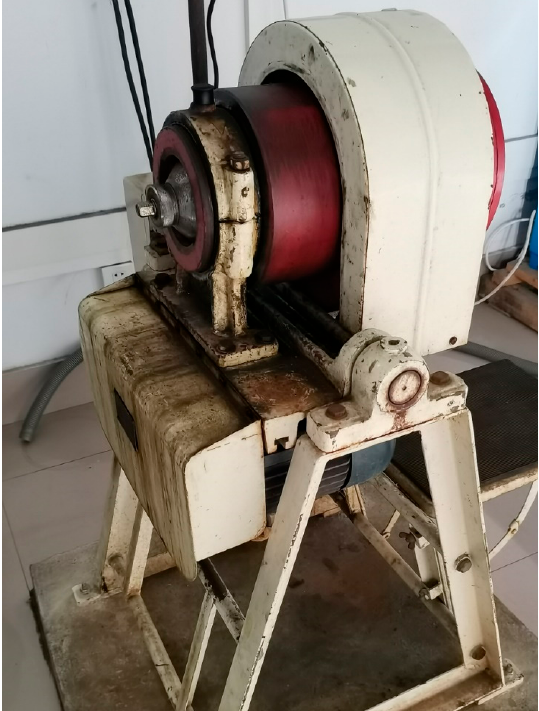
Figure 1. Picture of the tumbling mill.